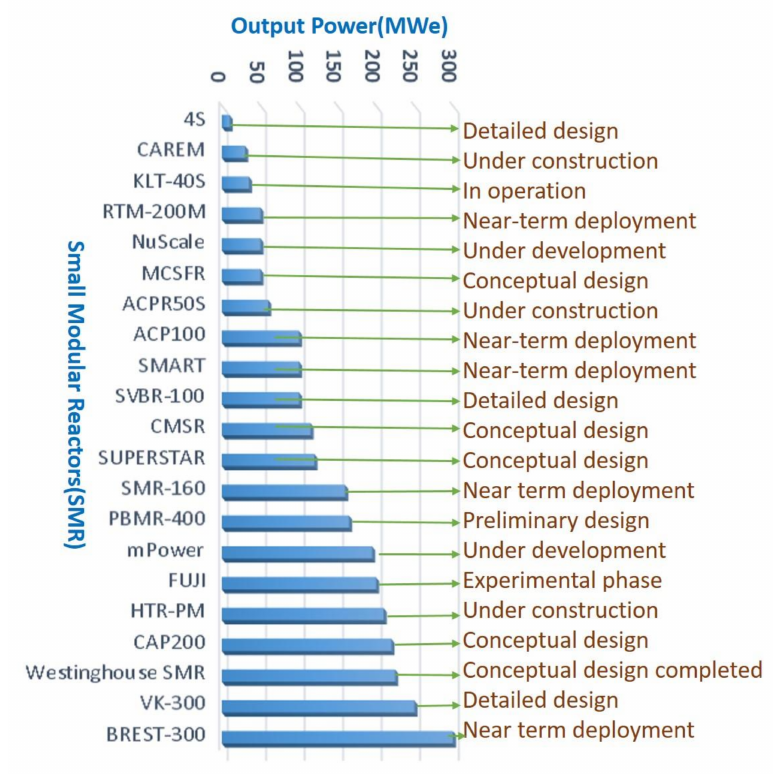
Figure 1. Small modular nuclear reactor with output and status